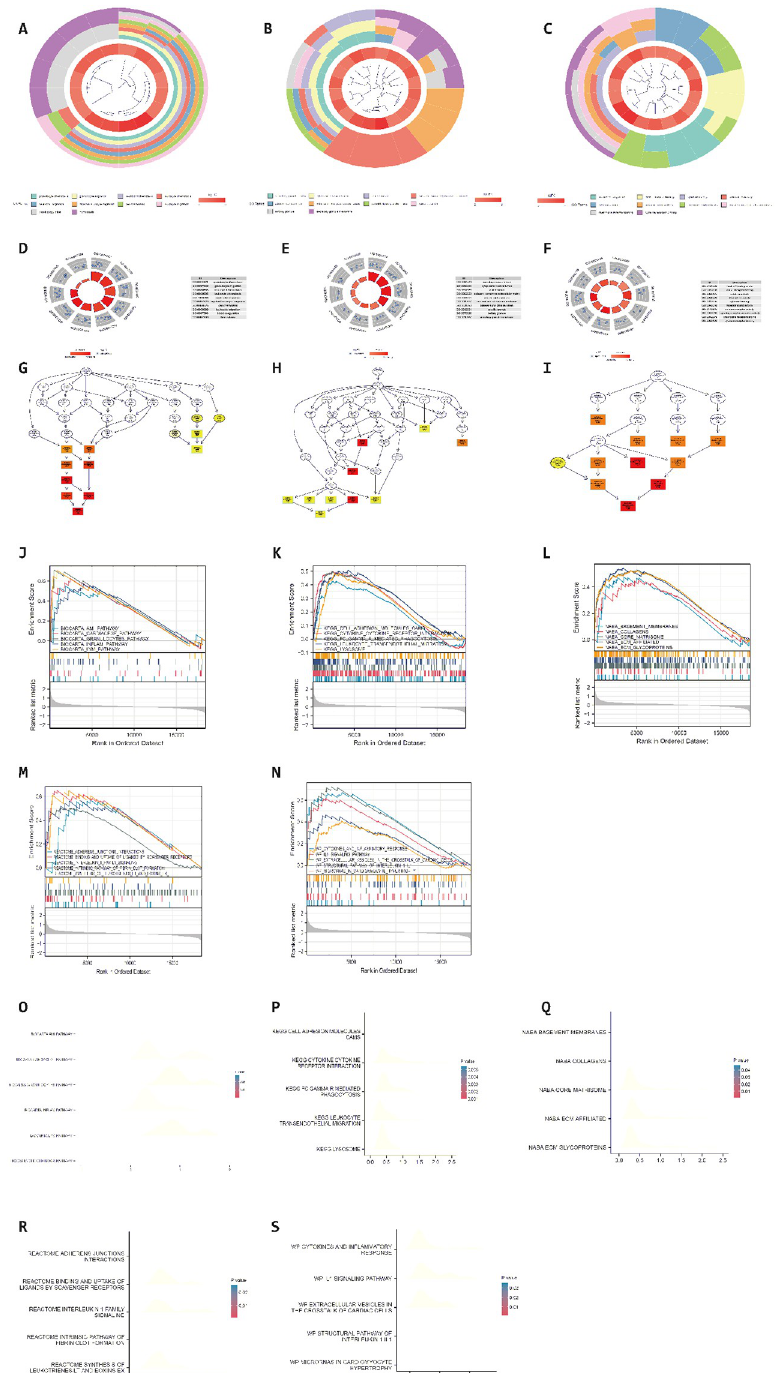
Fig 2. A, GO Circle plot of biological process . The GO circle plot of biological processes shows the biological processes of enrichment. The main enrichment processes are leukocyte chemotaxis:. B, GO Circle plot of cellular component . The GO circle plot of cellular constituents shows the enriched cellular component. The main enriched cellular component is collagen-containing extracellular matrix. C, GO Circle plot of molecular function . GO circles plot of molecular functions shows the enriched molecular functions. The main enriched molecular function is chemokine activity. D. GO Circle of biological process . GO circle of biological processes shows the enriched biological processes. The main enriched processes are granulocyte chemotaxis, granulocyte migration, neutrophil chemotaxis, leukocyte chemotaxis, neutrophil migration, myeloid leukocyte migration, cell chemotaxis, leukocyte